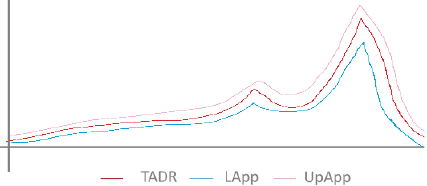
Figure 5. TADR with its lower and upper